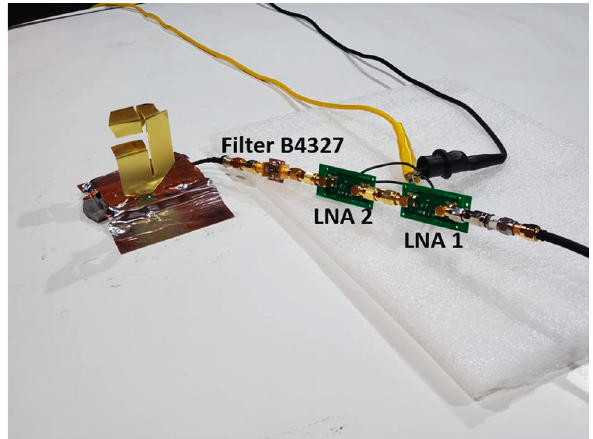
Figure 19: GNSS active antenna measurements setup on a vehicle.